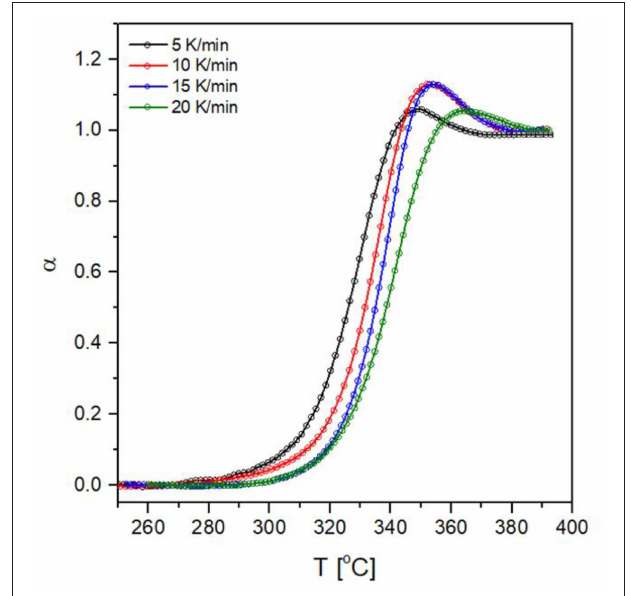
FIGURE 10 | Conversion against temperature curves for the glass transition of 80NaPO 3 – 20AlF 3 glass at four heating